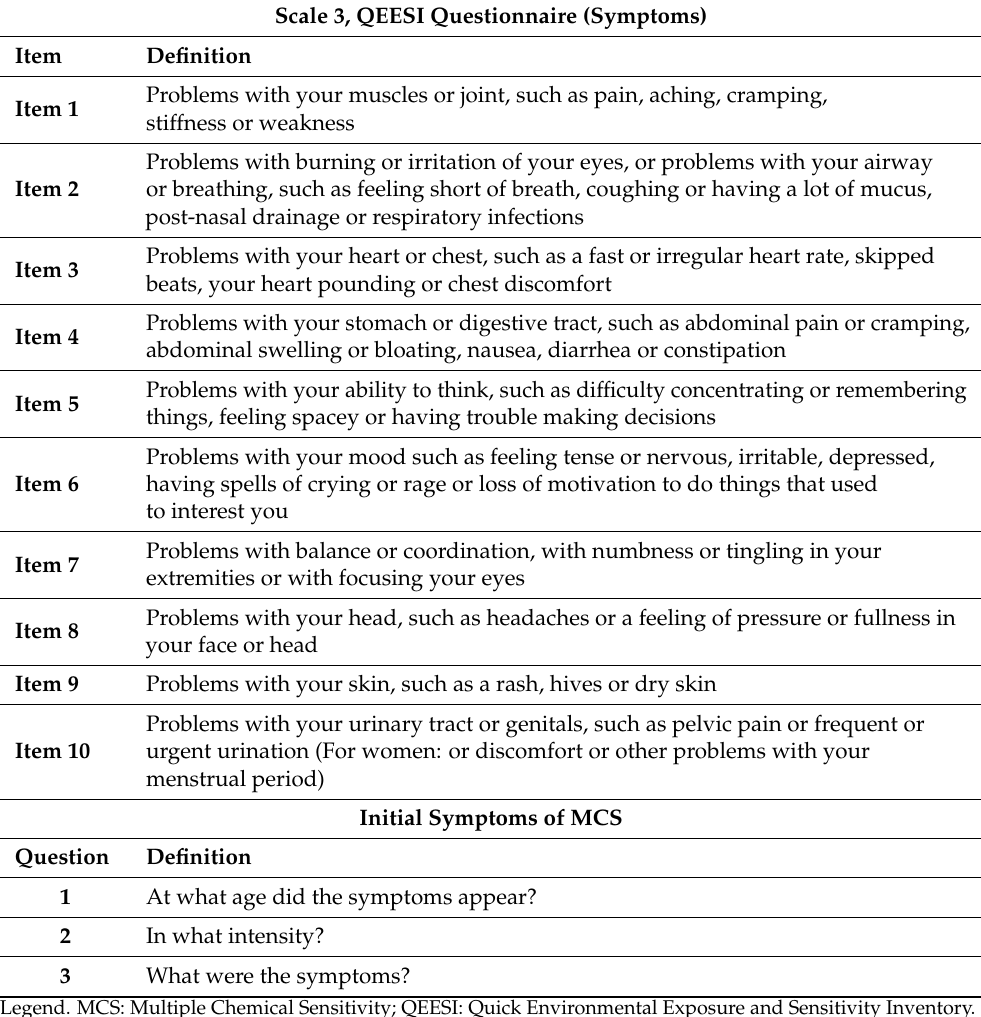
Table 2. Scale 3 QEESI questionnaire. Initial symptoms of